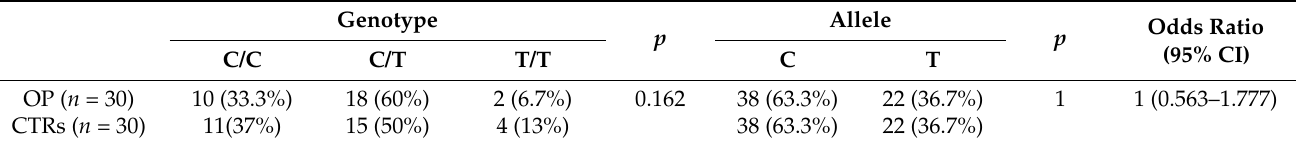
Table 3. Genotype distributions and allele frequencies of rs11136000 SNP in OP and CTR subjects. Genotype p